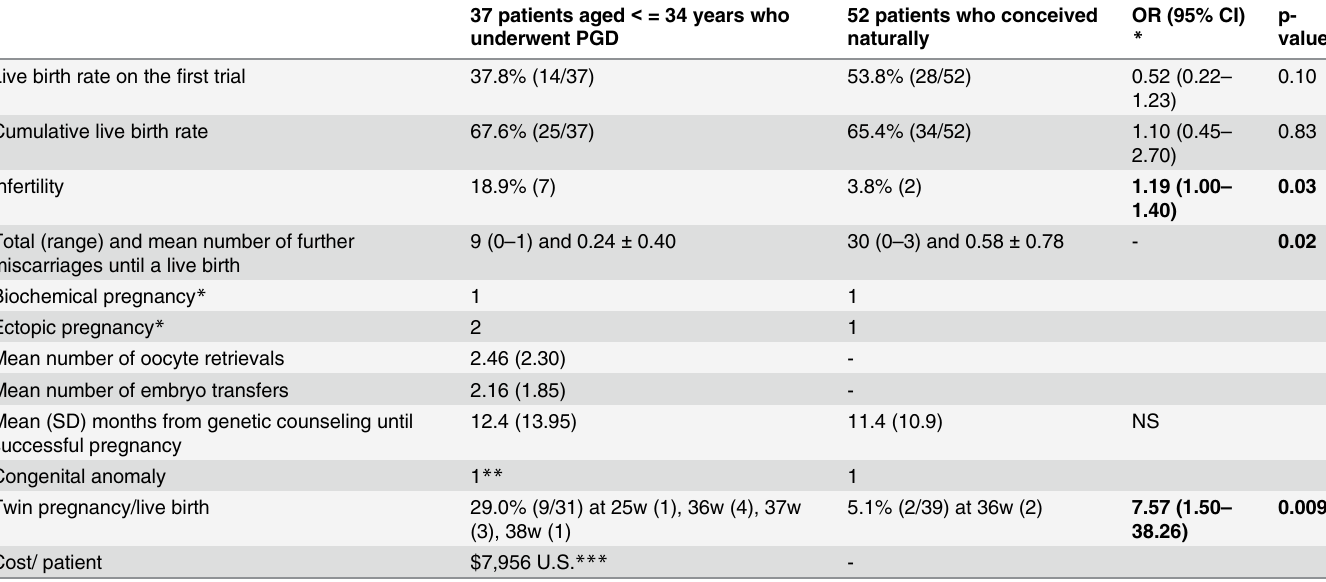
Table 4. Subsequent live birth rate in patients who underwent PGD or conceived